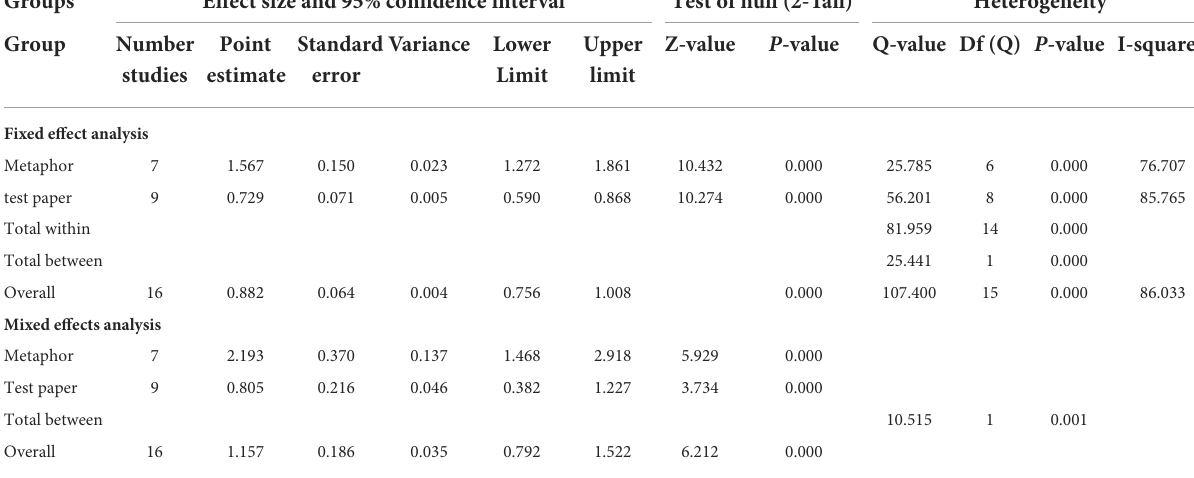
TABLE 5 Moderator analysis of measuring